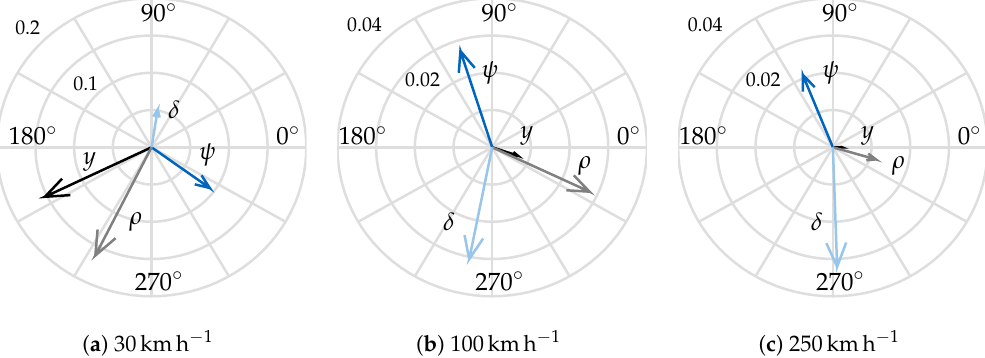
Figure 10. Compass plot of the weave eigenvector at different speeds. δ is the steering angle, ψ is the yaw angle, ρ is the roll angle and y is the lateral